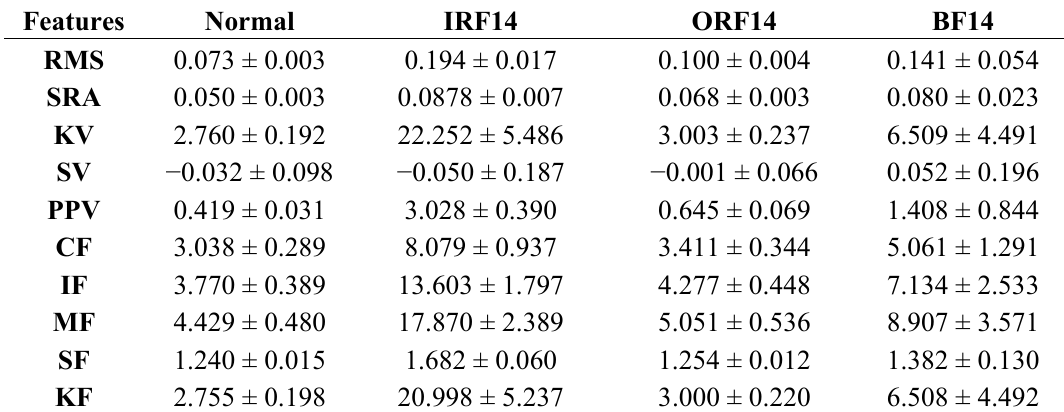
Table 3. The average value of the time domain features in the D_MIX